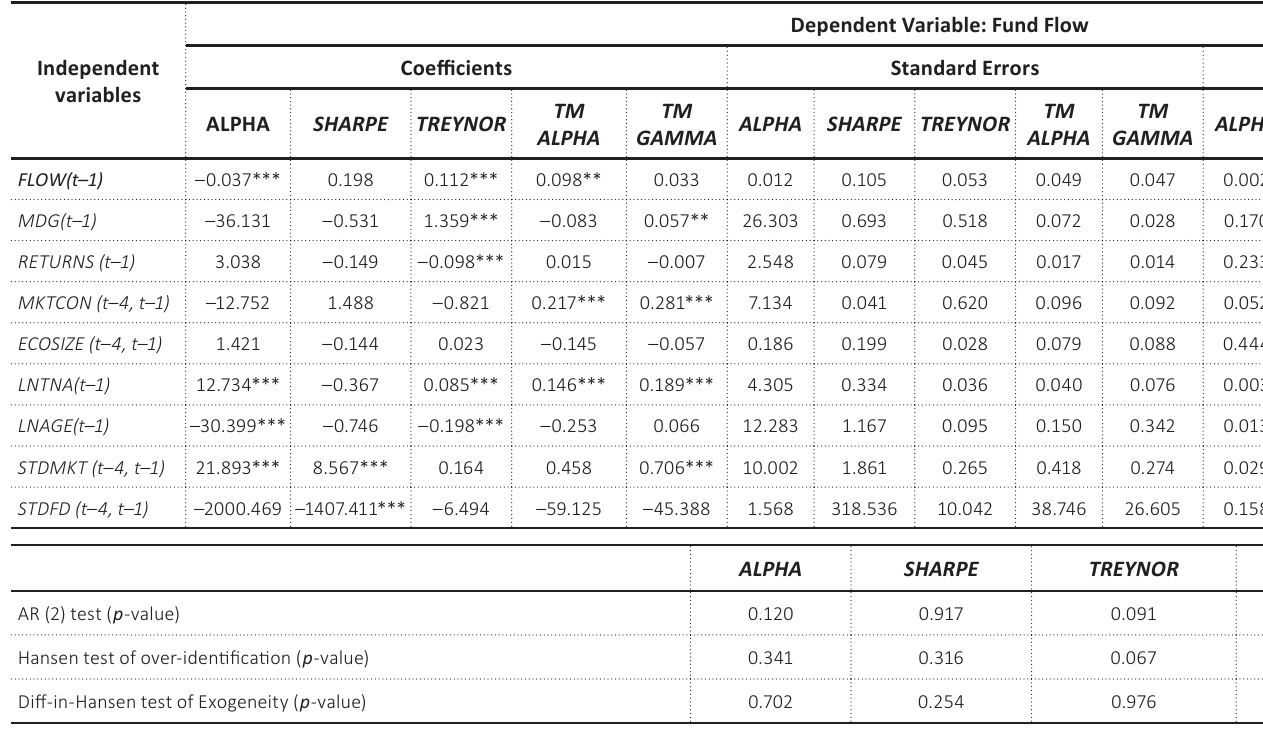
Source: Authors’ estimation